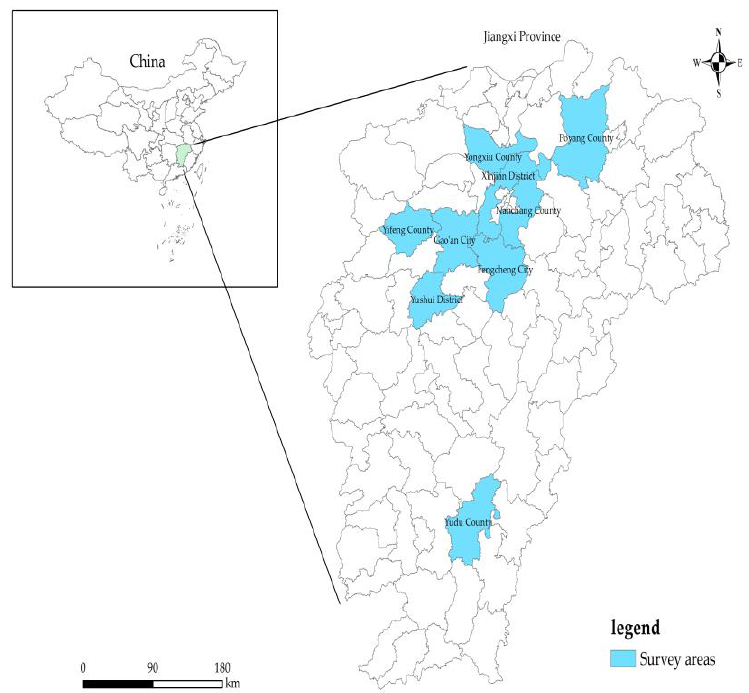
Figure 1. The location of the investigated area in this study.